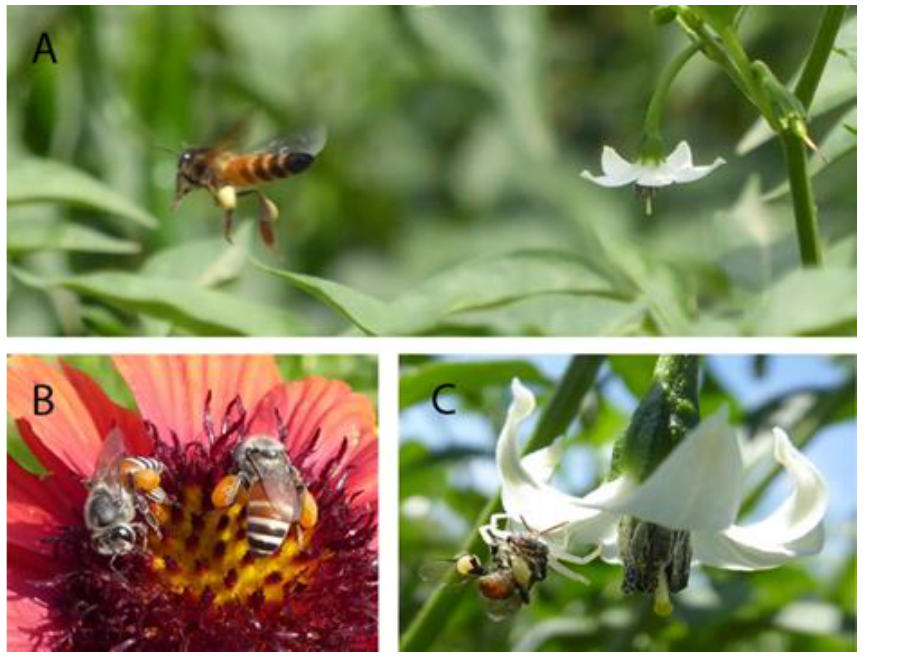
Figure 3. The three most common flower visitors A) Apis dorsata B) A. florea and C) Tetragonula irridipennis coll. (predated by a crab spider in the